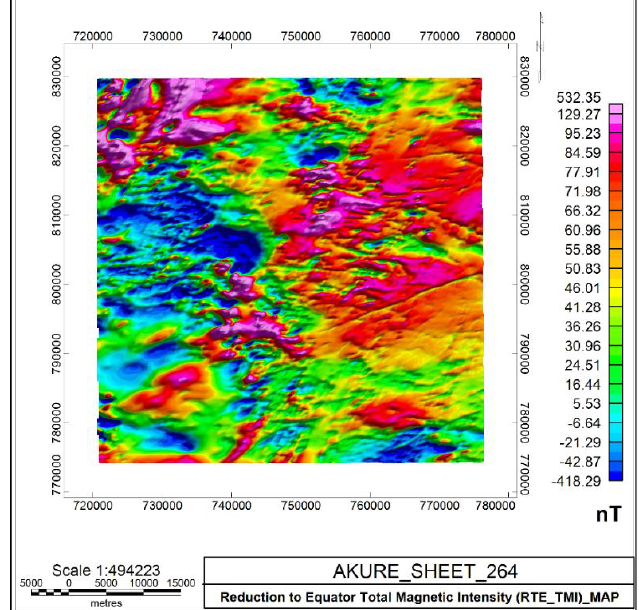
Figure 3: Colour Shaded Reduction to Equator Total Magnetic Intensity (RTE_TMI) Image.